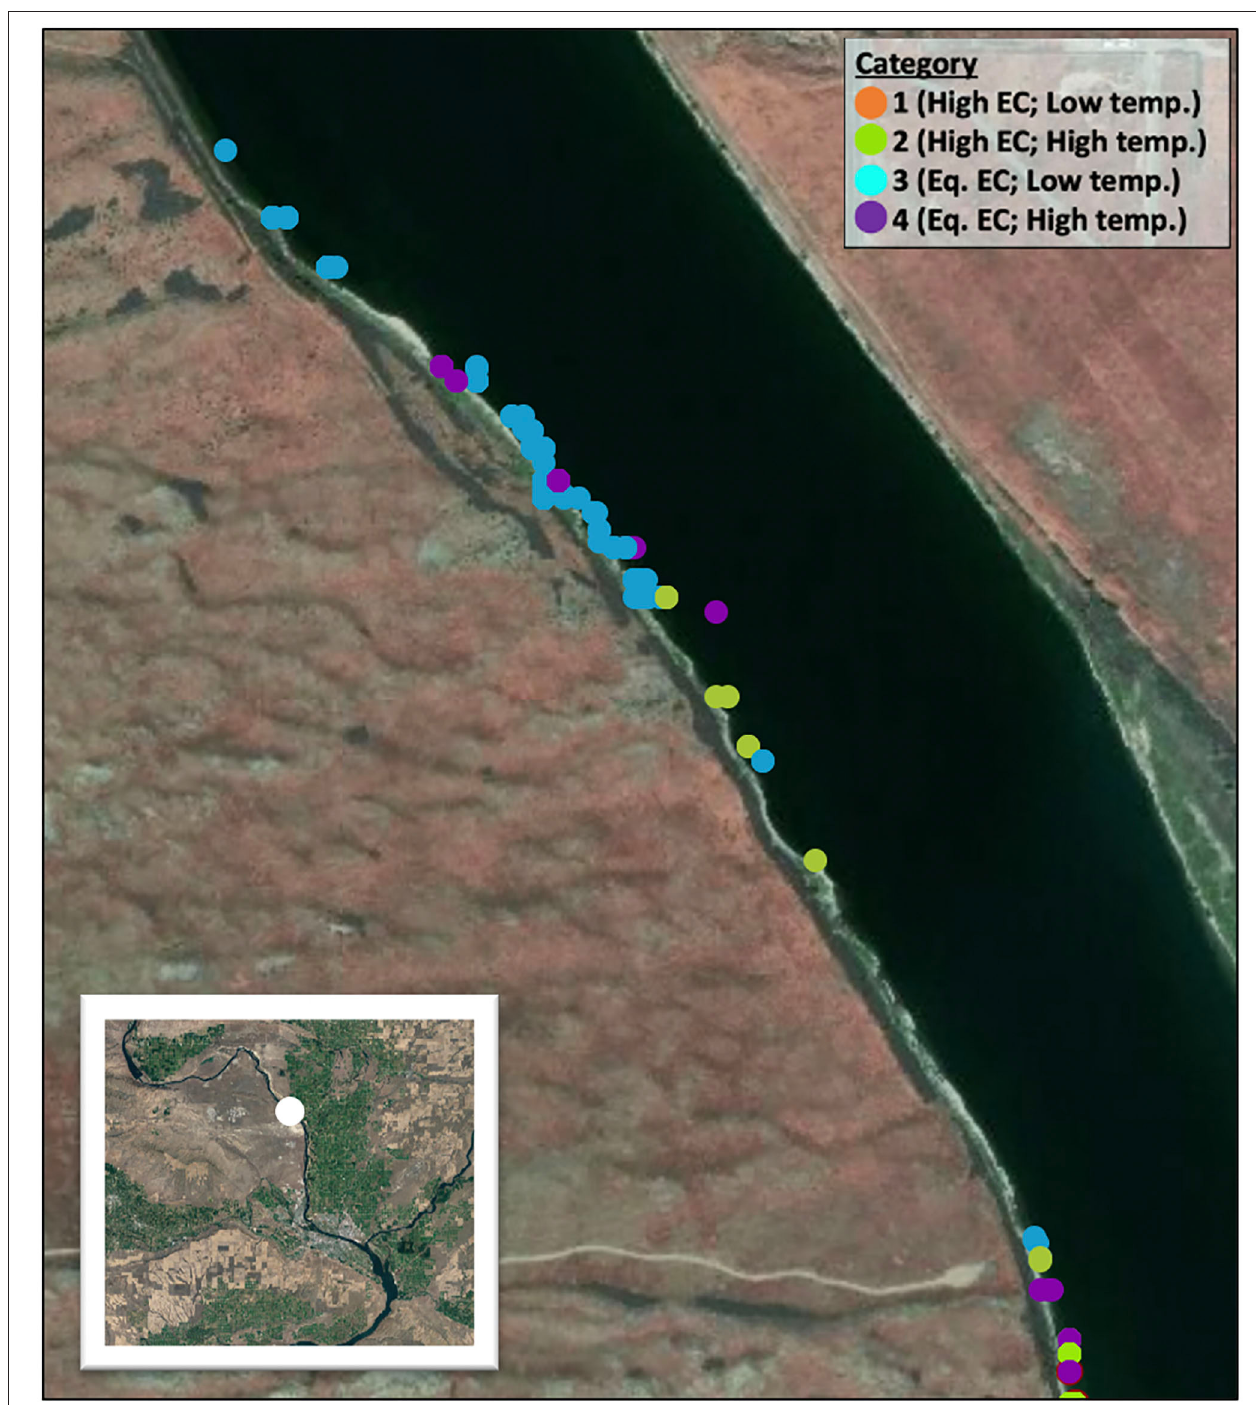
FIGURE 12 | Anomalies along non-irrigated land. The anomalies shown along the western shoreline of the Columbia River next to Savage Island are dominated by Category 3 anomalies. There are also some instances of Category 4 anomalies. Map data from Google, Landsat.